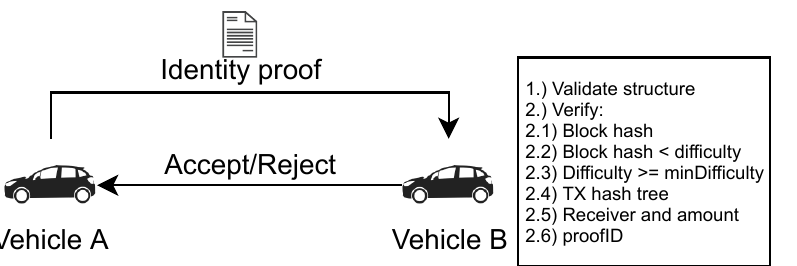
Figure 3. Validation process—based on